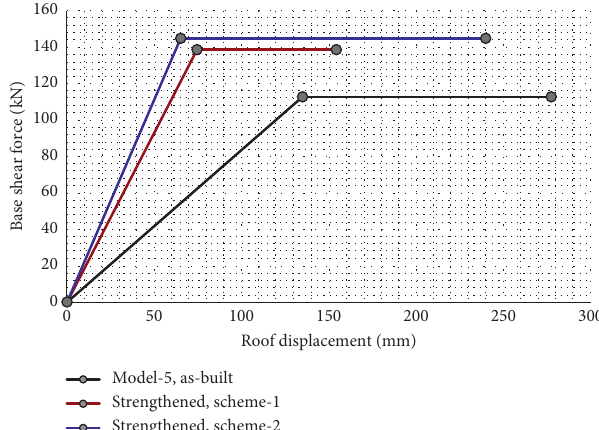
Figure 17: Bilinearized lateral force-deformation response of as- built and retrofitted RC